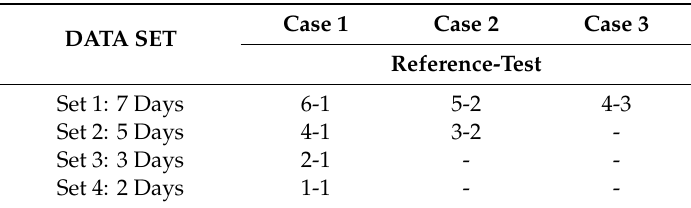
Table 1. Data sets and cases.